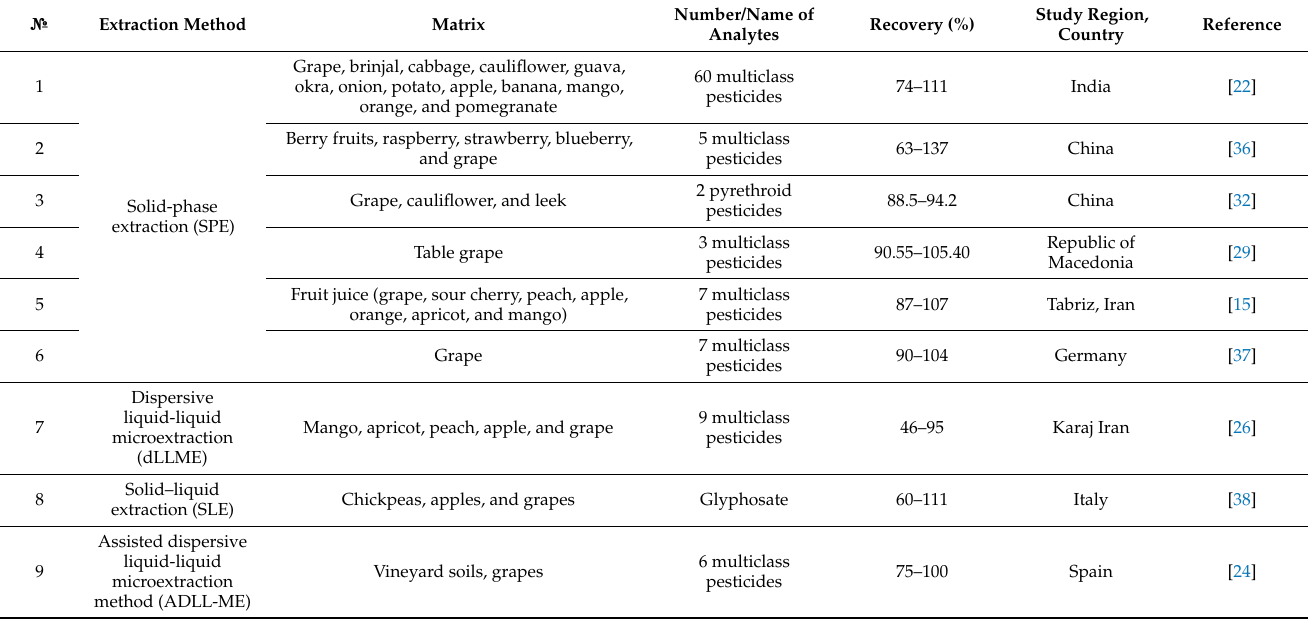
Table 2. Summarizing the extraction and pretreatment method for assessing pesticide residues in grapes 2015–2021 (Database Scopus, Web of